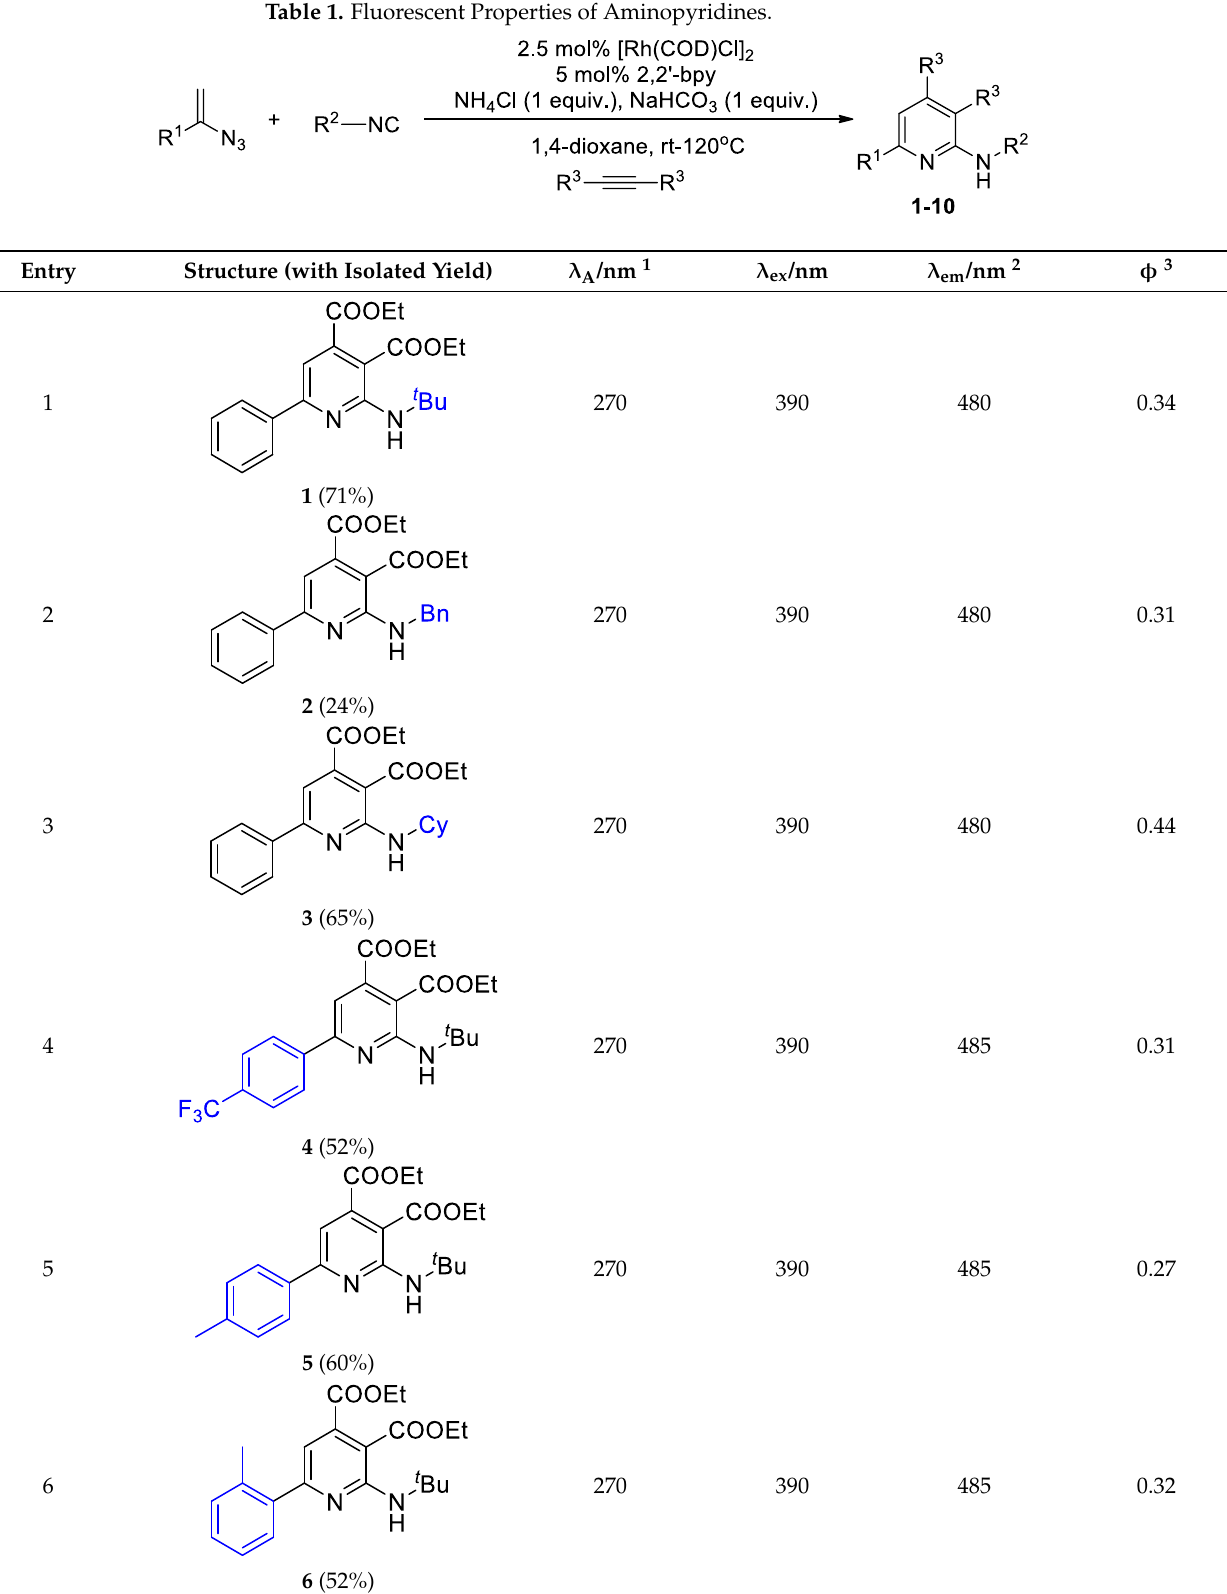
Table 1. Fluorescent Properties of Aminopyridines.